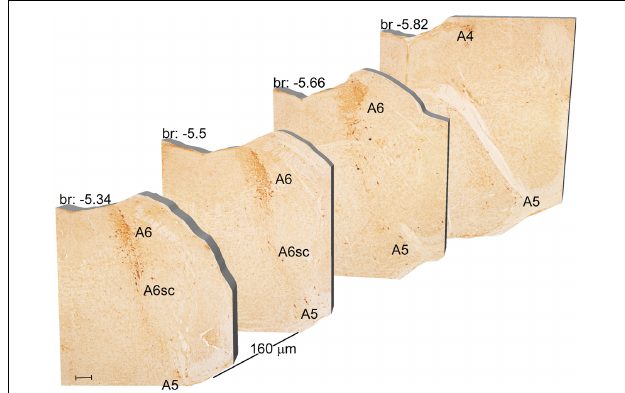
FIGURE 7 | Rostro-caudal reconstruction of the A6, A6sc, and A5 catecholaminergic nuclei. TH immunostaining in 20 µ m coronal mouse brain sections regularly collected every 160 µ m from –5.34 to –5.82 Bregma levels. The figure shows a 3D-like antero-posterior reconstruction of the A6, A6sc, and A5 catecholaminergic nuclei. Scale bar: 200 µ m.